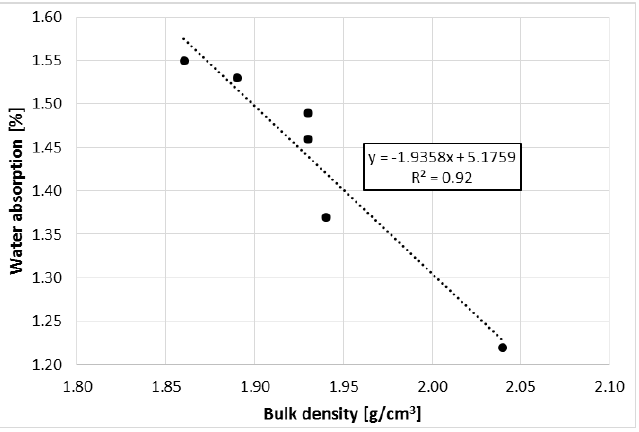
Figure 3. Water Absorption of the Polymer Concretes with RGA as a Function of Bulk Density.